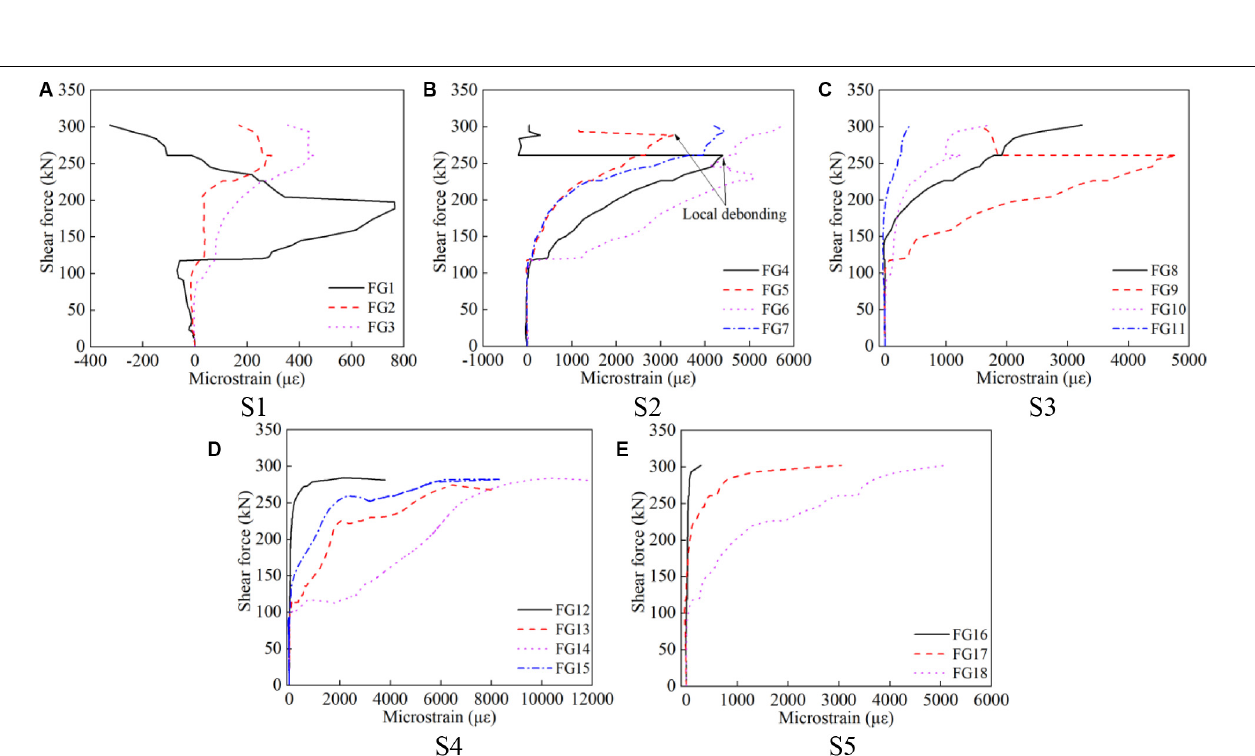
FIGURE 9 | Strain development in CFRP strips for HB-1-6. (A) S1, (B) S2, (C) S3, (D) S4, and (E) S5.